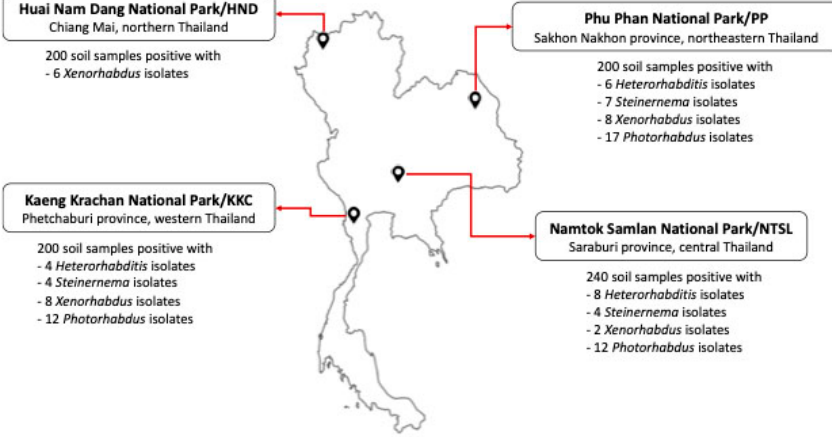
Figure 1. Map of Thailand shows the location of national parks where soil samples were collected. The number of identified positive EPN soil samples for each locality is